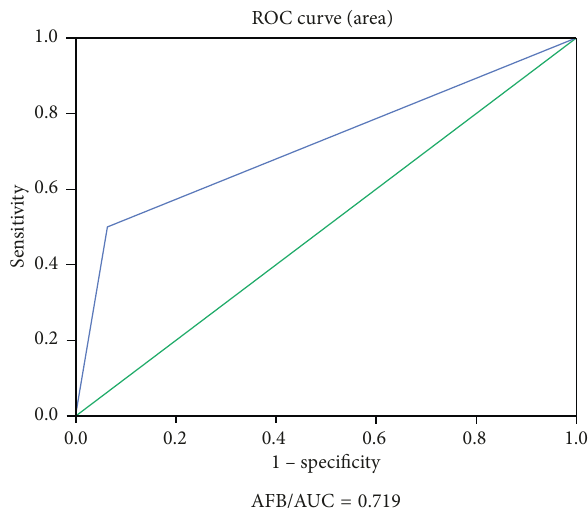
Figure 5: ROC of AFB in diagnosing